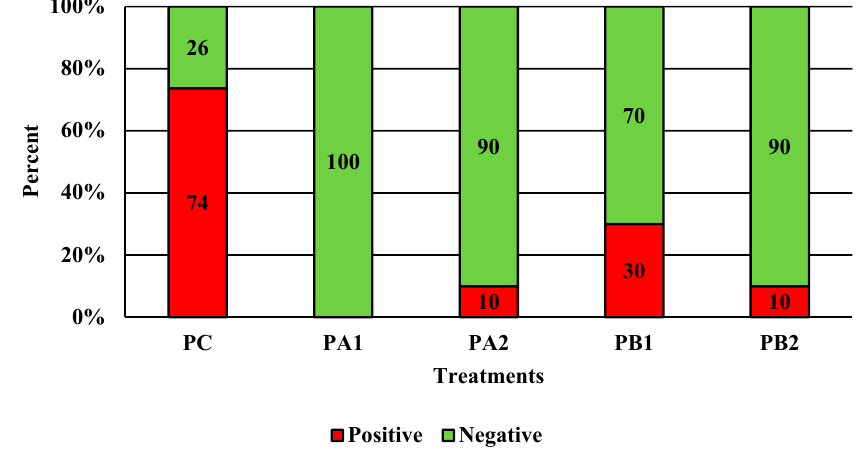
Figure 3. The effect of PeraClean, a PAA sanitizer, used as an antimicrobial dip (400 or 600 ppm) and in a stationary chilling tank (25 or 45 ppm) on the prevalence of Campylobacter present in the rinsates of 42-d-old Ross 708 broilers. N = 50, n = 10, p < 0.0001. PA1 refers to a 400 ppm / 25 ppm treatment, PA2 refers to a 400 ppm / 45 ppm treatment, PB1 refers to a 600 ppm / 25 ppm treatment, and PB2 refers to a 600 ppm / 45 ppm treatment, with each treatment being first a post-evisceration dip followed by an immersion chill.